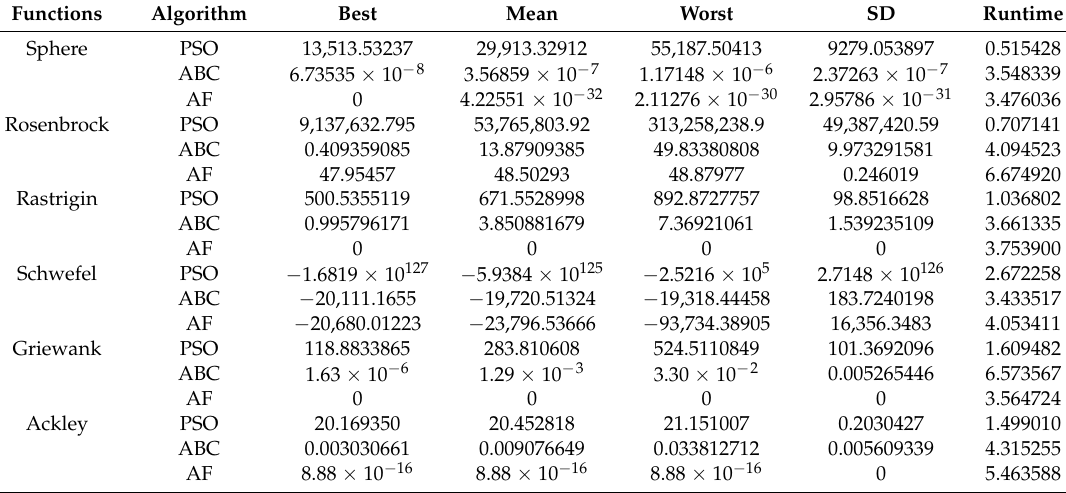
Table 6. Comparison of statistical results obtained by AF, PSO, and ABC in 50-dimensional